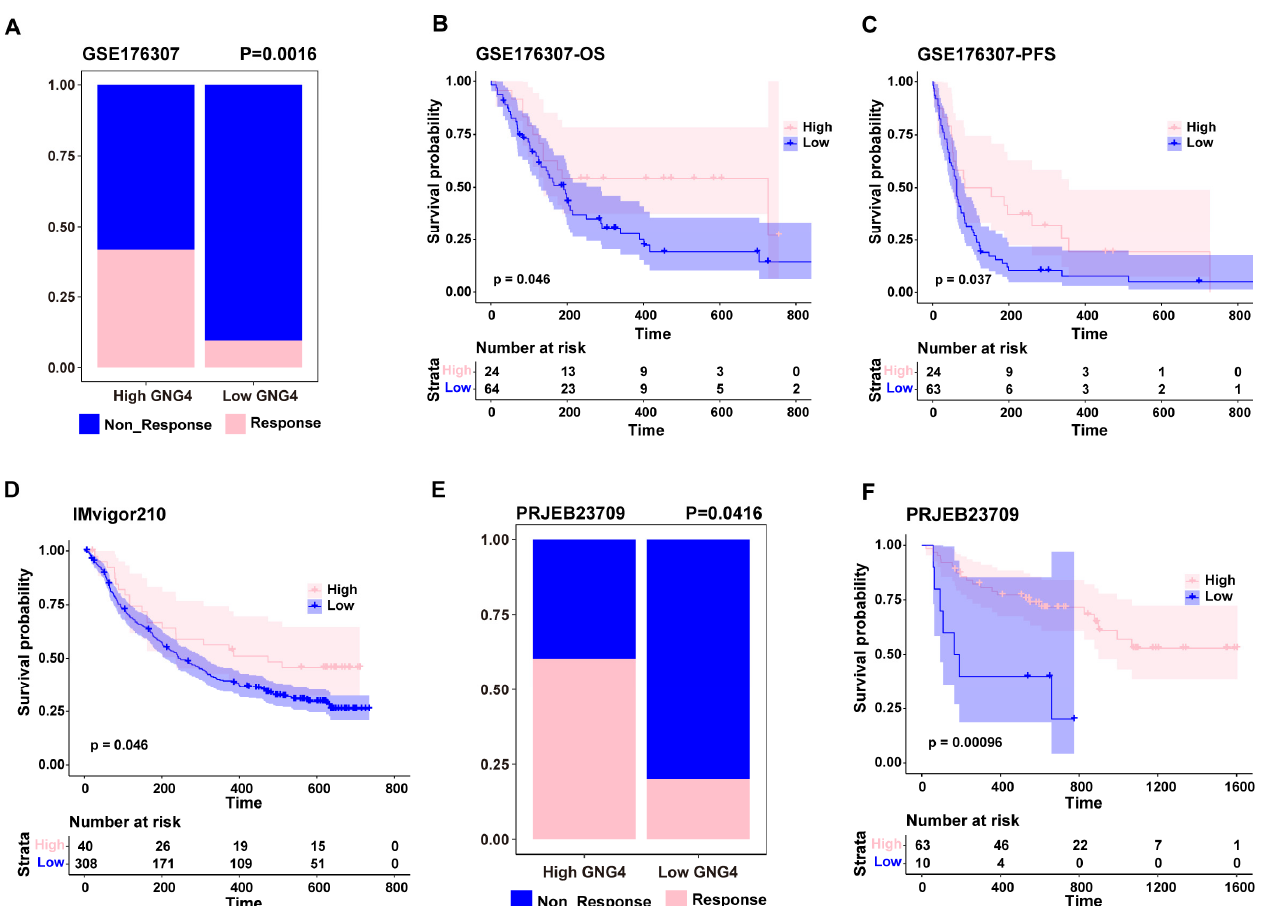
Figure 3. GNG4 as a biomarker to predict the effect of immunotherapy. ( A ). Boxplots showing the proportion of responders between high-GNG4 and low-GNG4 groups in the GSE176307 cohort. Overall survival ( B ) and progression-free survival ( C ) analysis between high-GNG4 and low-GNG4 groups that received immunotherapy in the GSE176307 cohort. ( D ). Overall survival analysis between high-GNG4 and low-GNG4 groups that received immunotherapy in the IMvigor210 cohort. ( E ). Boxplots showing the proportion of responders between high-GNG4 and low-GNG4 groups in the PRJEB23709 cohort (SKCM). ( F ). Overall survival analysis between high-GNG4 and low-GNG4 groups that received immunotherapy in the PRJEB23709 cohort (SKCM).